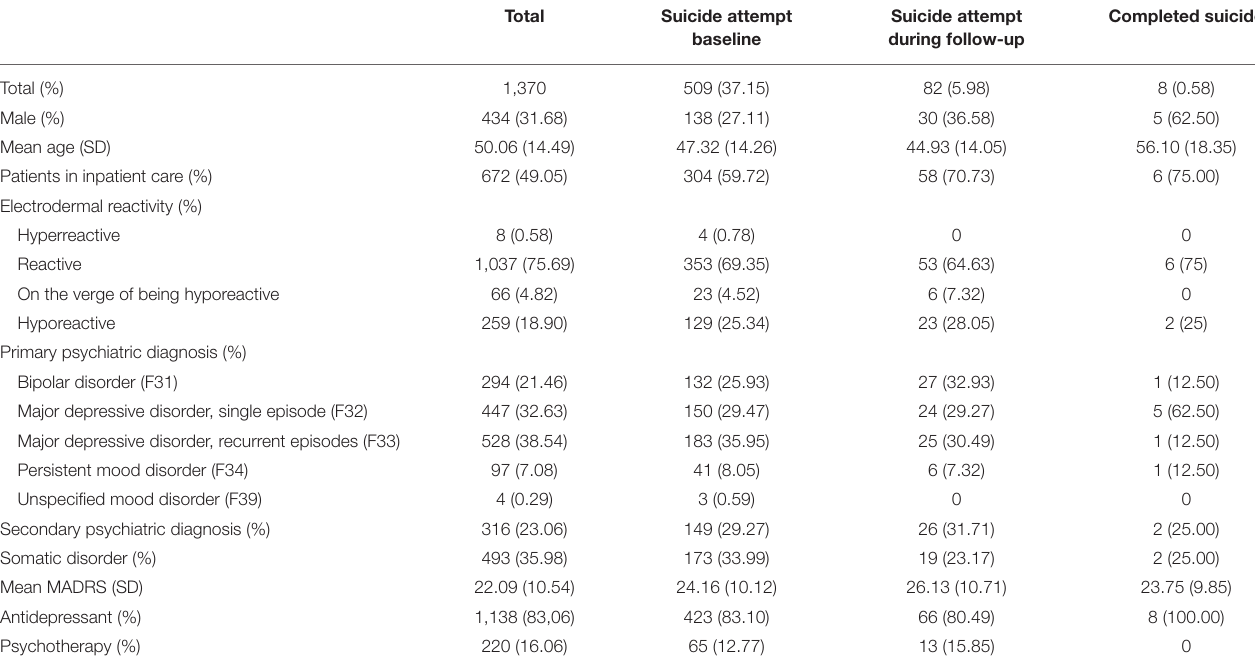
TABLE 1 | Sociodemographic and clinical characteristics of the study population at baseline.